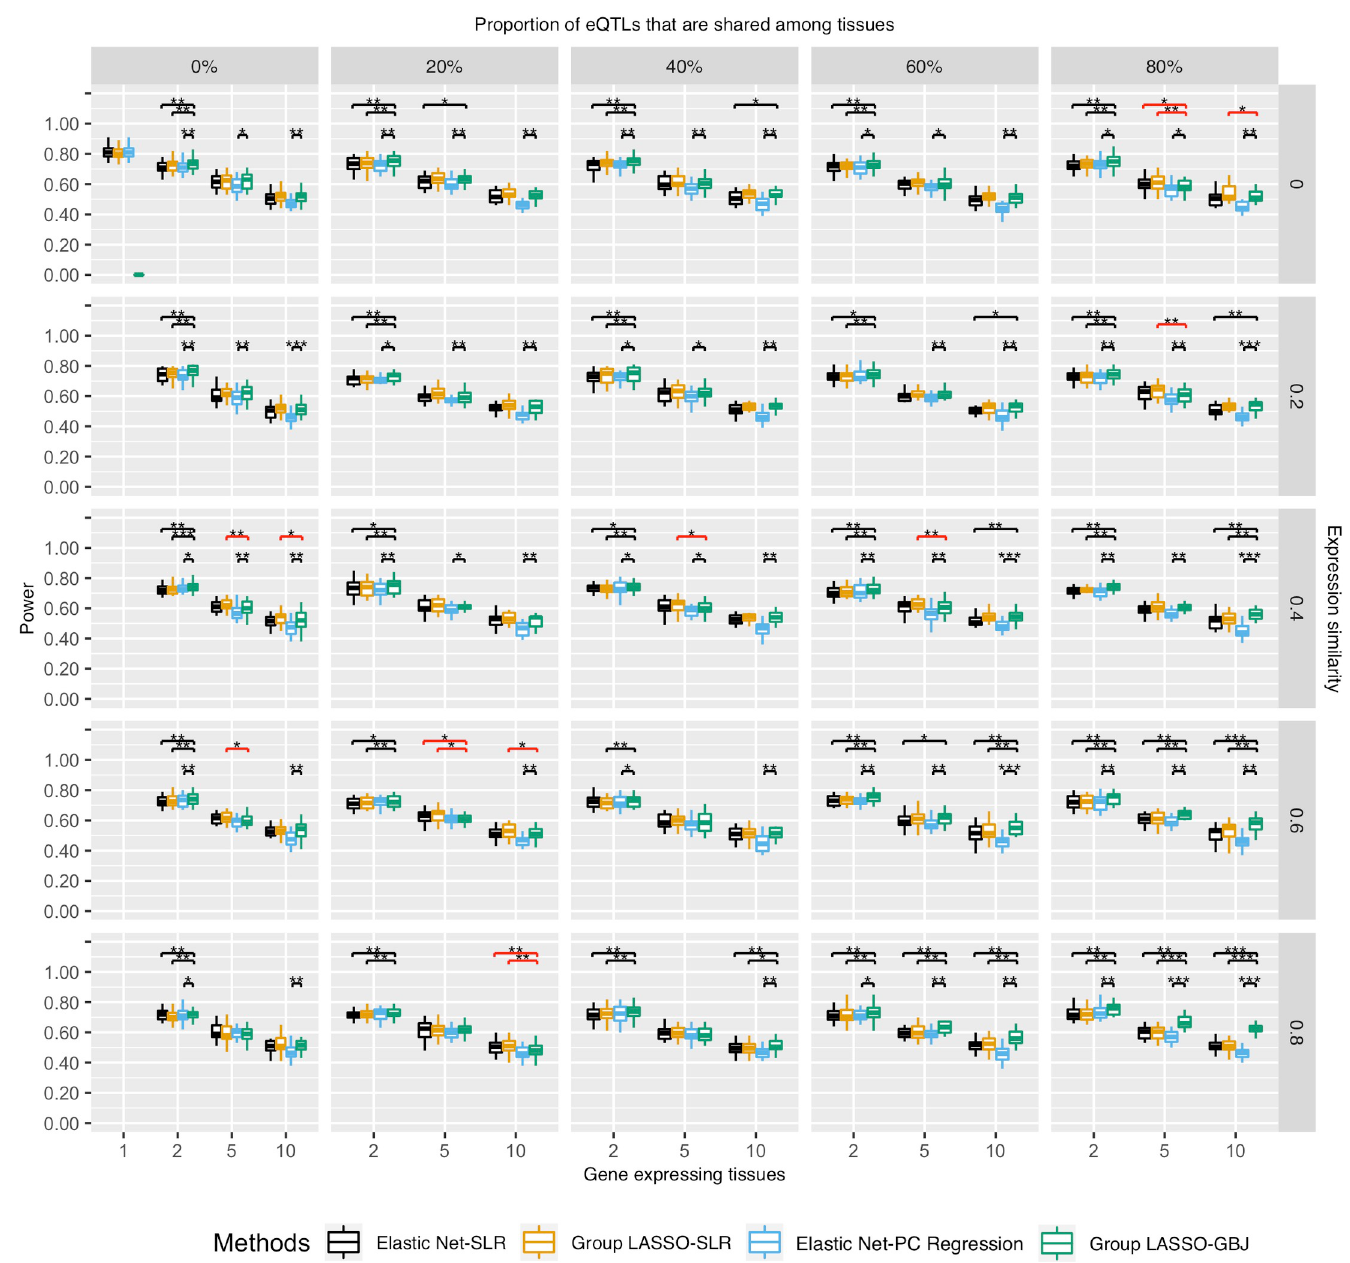
Fig 2. Power of different TWAS methods in prioritizing genes of varied tissue specificity properties. Power was the proportion of successfully identified gene-trait associations in the causal tissue out of all simulations. X-axis is the number of gene-expressing tissues. Each column stands for the proportion of eQTLs that are shared among tissues for a gene. Each row is the similarity of gene expression profiles across tissues which is estimated by correlation. Moving from the top left to the bottom right is a gradient spectrum from tissue-specific genes to broadly expressed genes. The colors represent different TWAS methods and y-axis is the power. For tissue- specific genes at the top left, single-tissue TWAS (Elastic Net-SLR) and cross-tissue TWAS (Group LASSO-GBJ) had similar power. For broadly expressed genes at the bottom right, cross-tissue TWAS (Group LASSO-GBJ) had greater power. Brackets showed pairwise comparison of power between the Group LASSO-GBJ and other TWAS methods using Wilcoxon Signed-rank Test. Black brackets were cases where Group LASSO-GBJ had higher power than other three methods; red brackets were cases where Group LASSO-GBJ had lower power than other three methods. � p-value < 0.05, �� p-value < 0.01, ��� p-value < 0.0001.